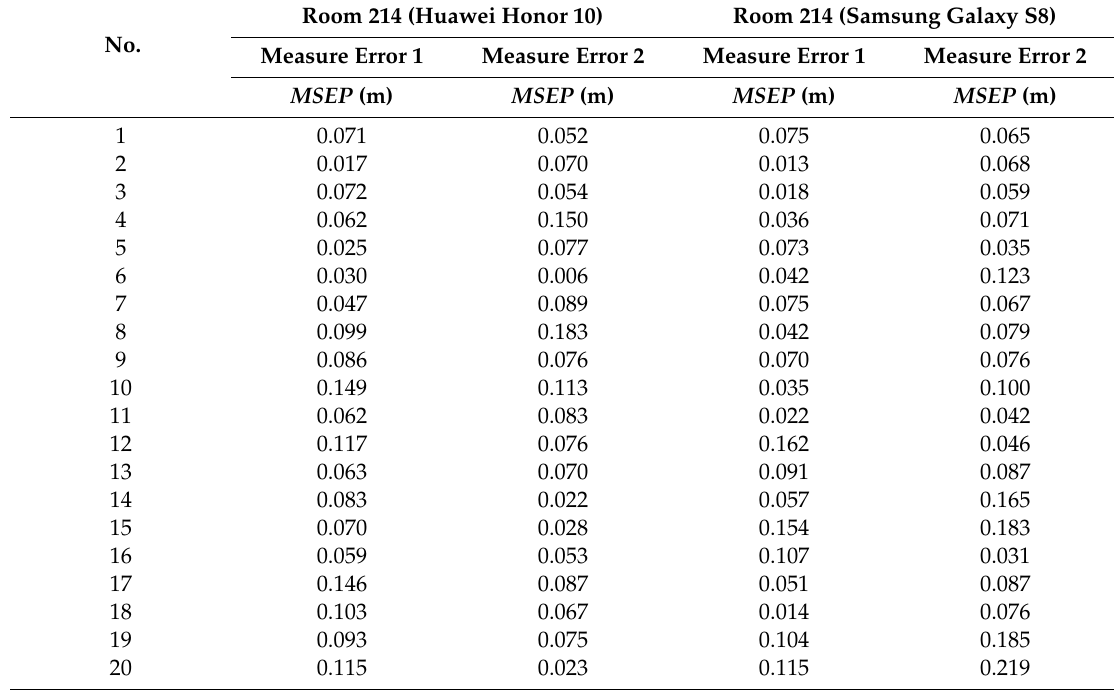
Table 6. Positioning accuracy of the smartphones in Room 214.